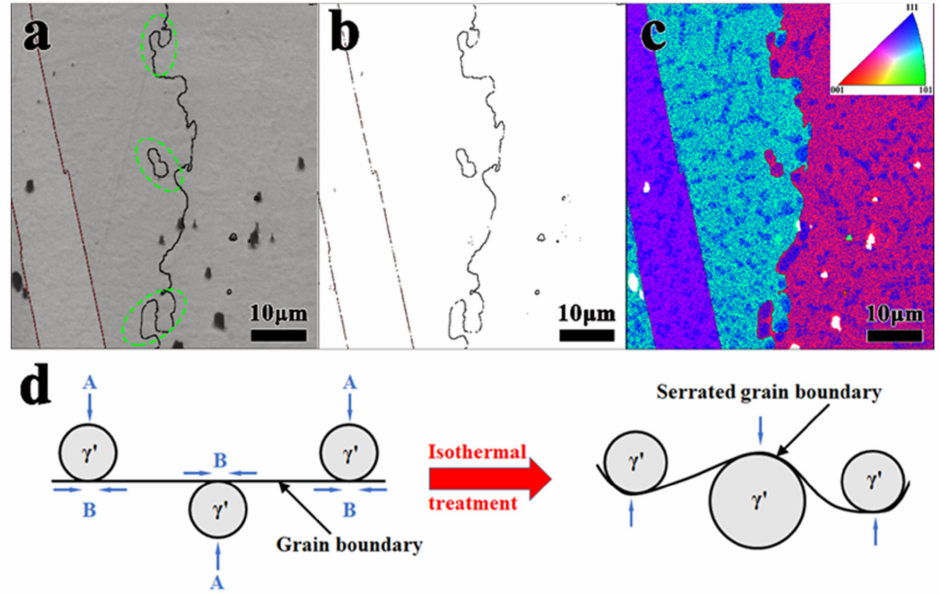
Figure 11. The typical microstructure of the serrated grain boundaries and precipitates after isother- mal treatment: ( a ) band contrast map; ( b ) grain boundary maps; ( c ) IPF map; ( d ) schematic map for γ ’ phase promoting the formation of serrated grain